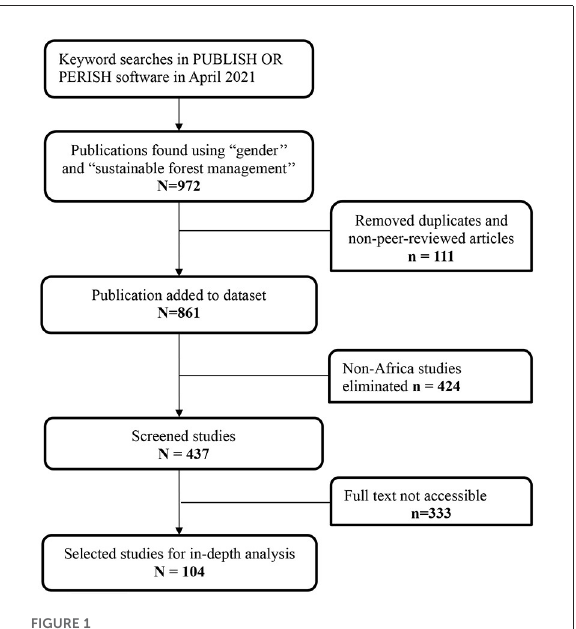
FIGURE1 Systematic review of women’s engagement in